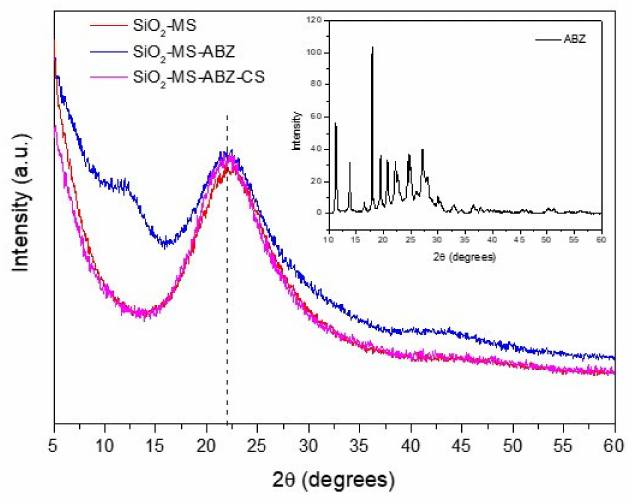
Figure 2. X-Ray powder diffraction patterns for the nanoparticles. Inset: pure Albendazole XRD